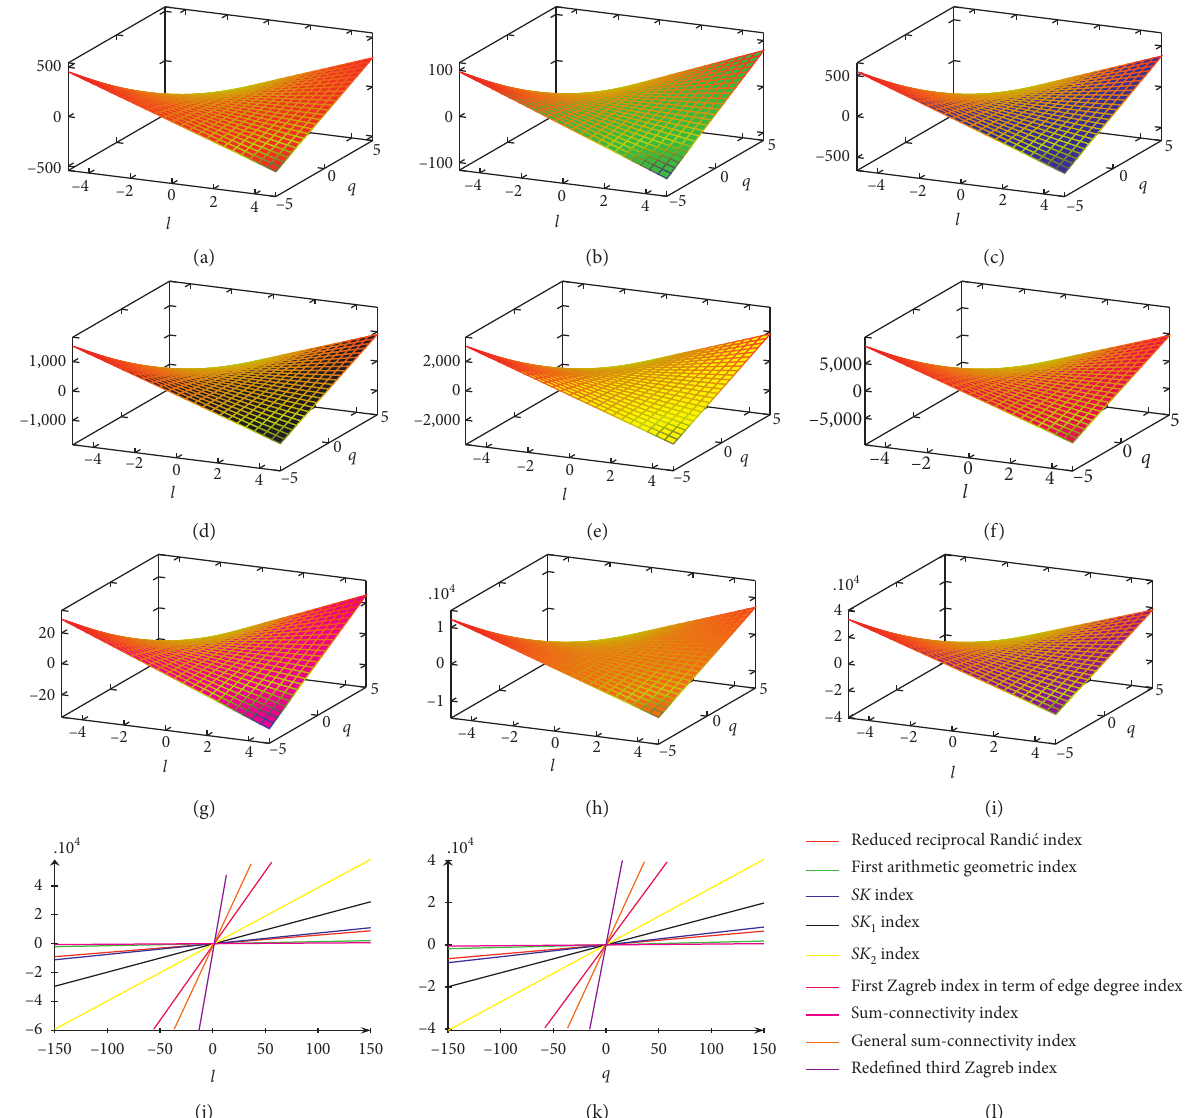
Figure 3: Plot of topological indices of boron α -nanotube: (a) reduced reciprocal Randi´c index; (b) arithmetic-geometric index; (c) SK index; (d) SK 1 index; (e) SK 2 index; (f) edge version of first Zagreb index; (g) sum connectivity index; (h) general sum connectivity index;